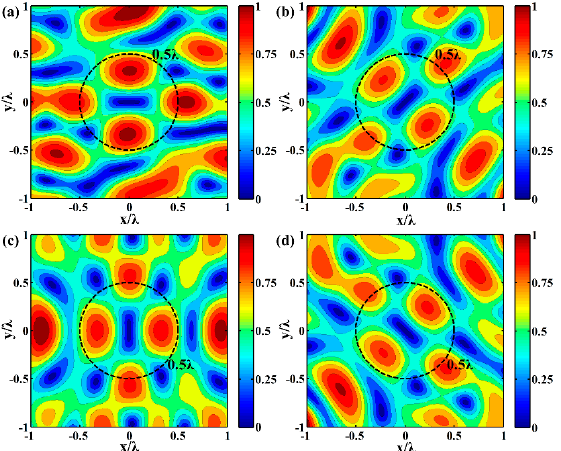
Figure 3. Anticlockwise rotation of the synthesized pressure field from 0 ◦ to 135 ◦ with 45 ◦ interval: ( a ) 0 ◦ ; ( b ) 45 ◦ ; ( c ) 90 ◦ ; ( d ) 135 ◦